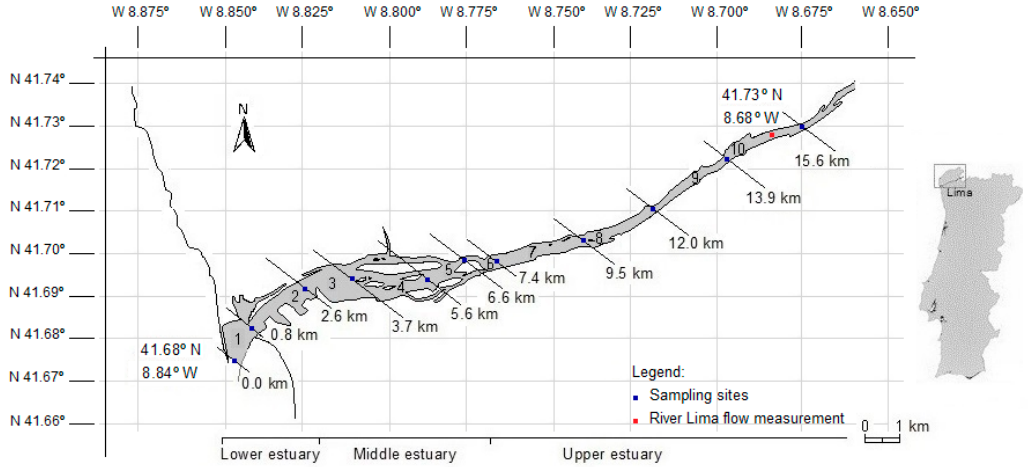
Figure 1. Map of the Lima estuary, sampling locations, and box boundaries used in the model.